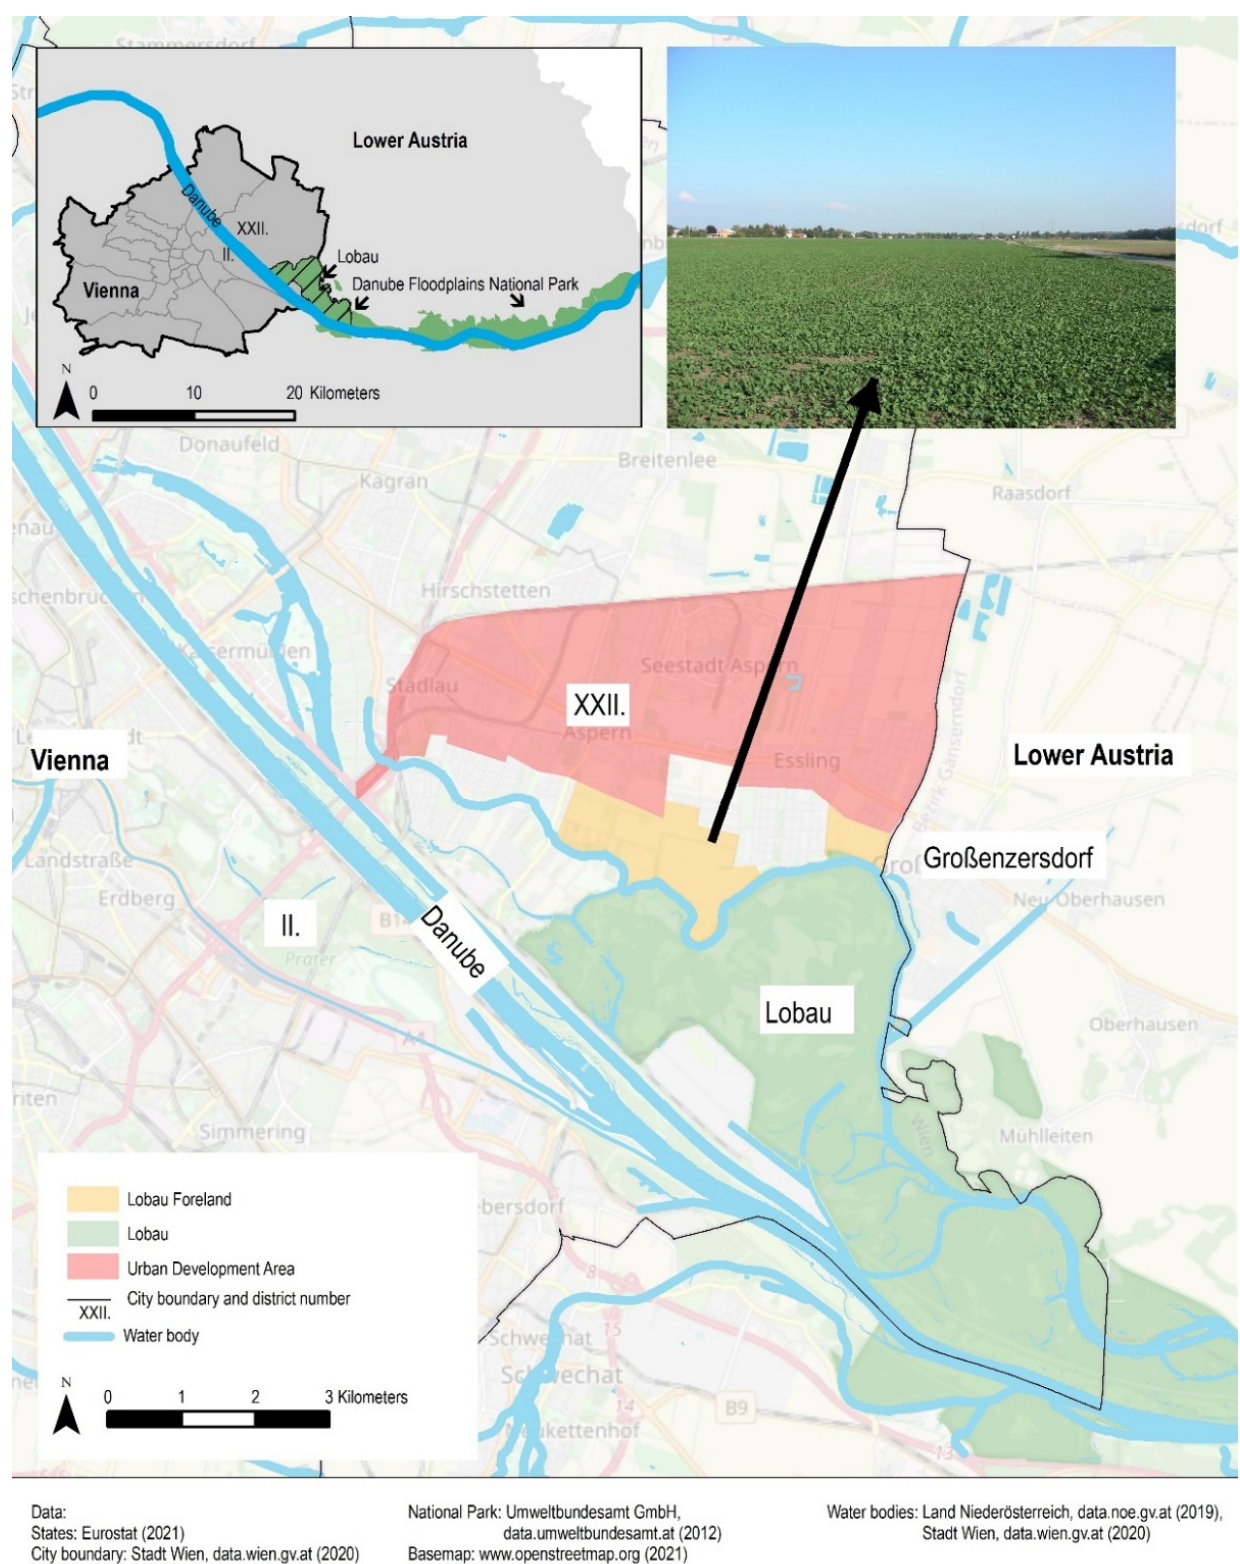
Figure 1. Location of the Danube Floodplains National Park in East Austria, the Viennese Lobau and the surrounding Lobau foreland. The foreland is dominated by agrarian areas and settlements (Photo: Arnberger).